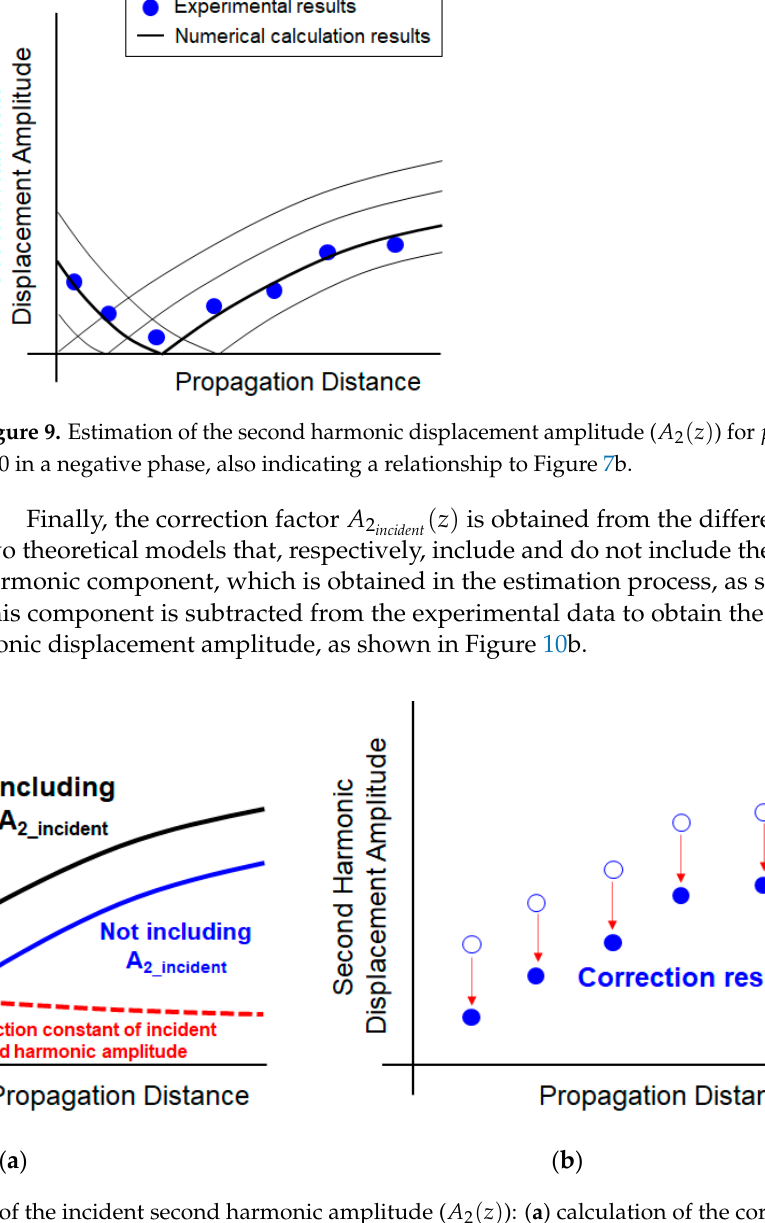
Figure 10. Correction process of the incident second harmonic amplitude ( A 2 (z) ): ( a ) calculation of the correction factor and ( b ) correction of the experimental data.